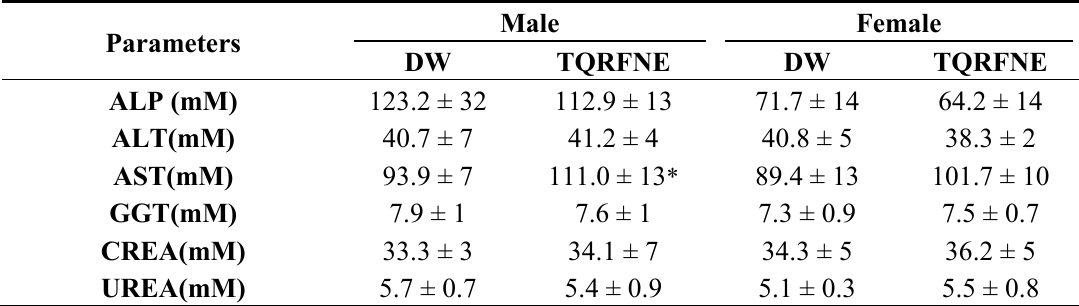
Table 3. Effects of oral administration of thymoquinone-rich fraction nanoemulsion (TQRFNE) and distilled water (DW) on liver and kidney function tests of male and female